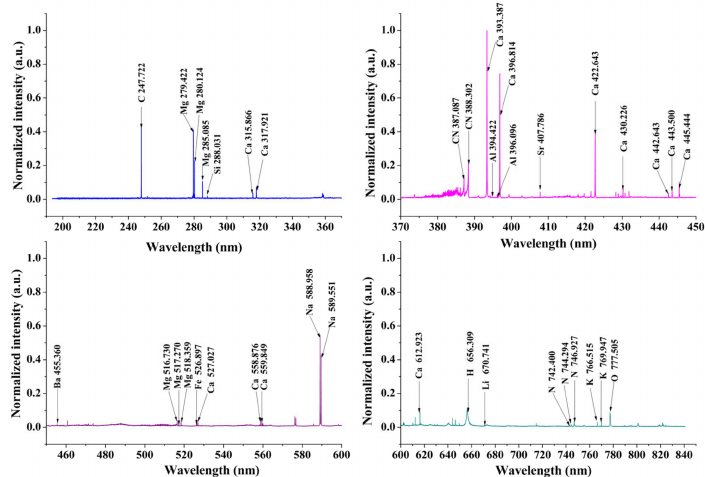
Figure 1. The representative normalized LIBS spectrum of the CCA